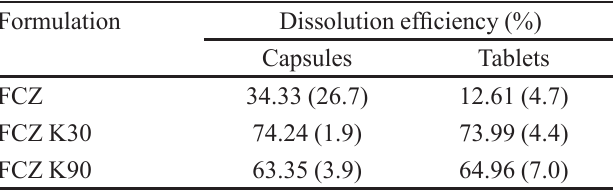
TABLE VI - Dissolution efficiency of fluconazole from capsules and tablets produced with FCZ and granules (FCZ K30 and FCZ K90). N=4